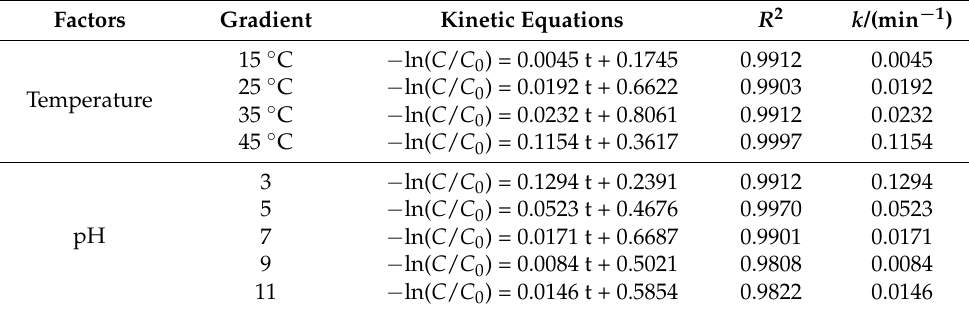
Figure 8. ( a ) Effect of temperature on the degradation of DTZ. [DTZ] = 20 mg L − 1 ; [nZVI/2BC] = 0.45 g L − 1 ; [PS] = 25.0 mM; pH= 7.0. ( b ) Effect of pH on the degradation of DTZ. ( c ) Corresponding kinetic curves of DTZ with different temperatures. ( d ) Corresponding kinetic curves of DTZ with different pH values [DTZ] = 20 mg L − 1 ; [nZVI/2BC] = 0.45 g L − 1 ; [PS] = 25.0 mM; Temp = 25 °C. Table 1. The kinetic parameters of DTZ removal by different temperatures and pH. Factors